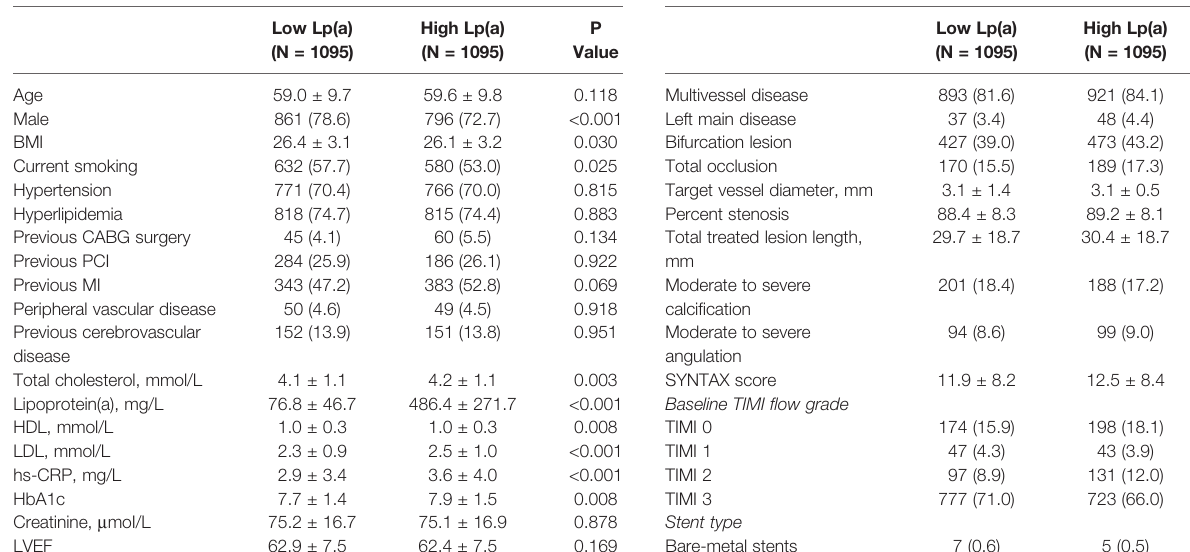
TABLE 1 | Baseline characteristics of study patients. TABLE 2 | Procedural characteristics of study